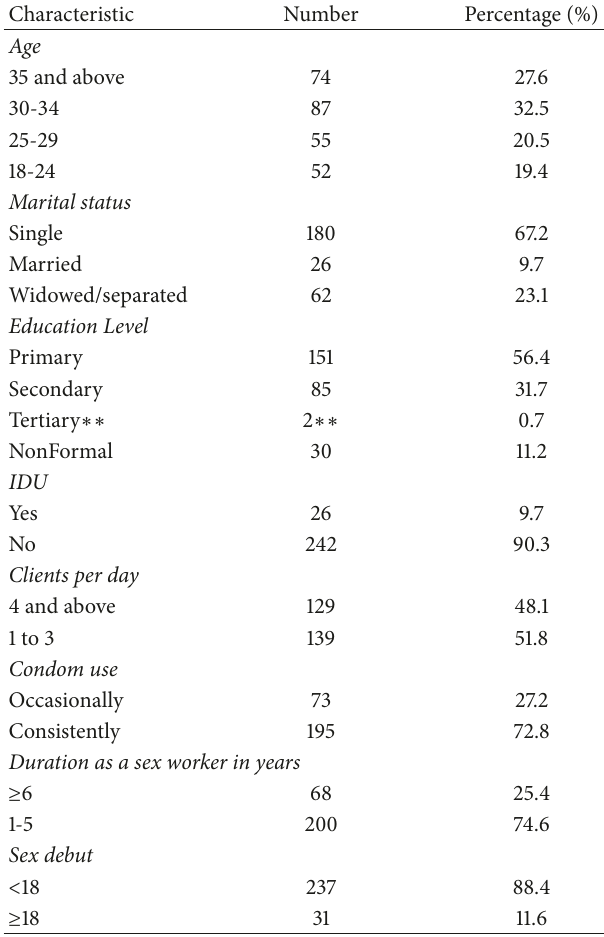
Table 1: Basic characteristics for female sex workers in Malindi, Kenya in